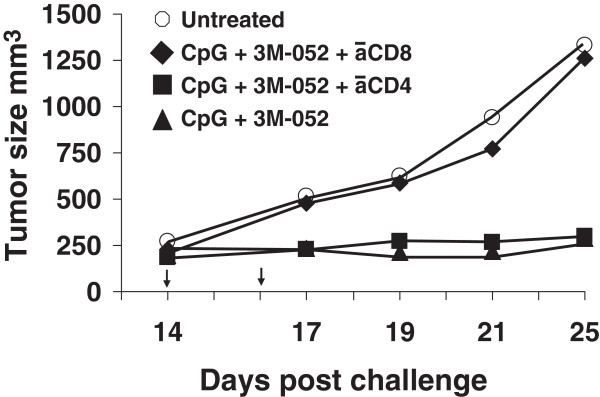
Effect of depleting CD8 T cells on immune mediated protection. CT26 tumors were implanted into BALB/c mice and treated with 100 μg of CpG and 50 μg of 3M as described in Figure 
1. The effect of depleting CD4 or CD8 T cells on tumor growth was determined as described in the Methods section. Data show the change in tumor volume (mean + SE) of 5 mice/group. *, p < 0.05; **, p <0.01 compared with the control group.